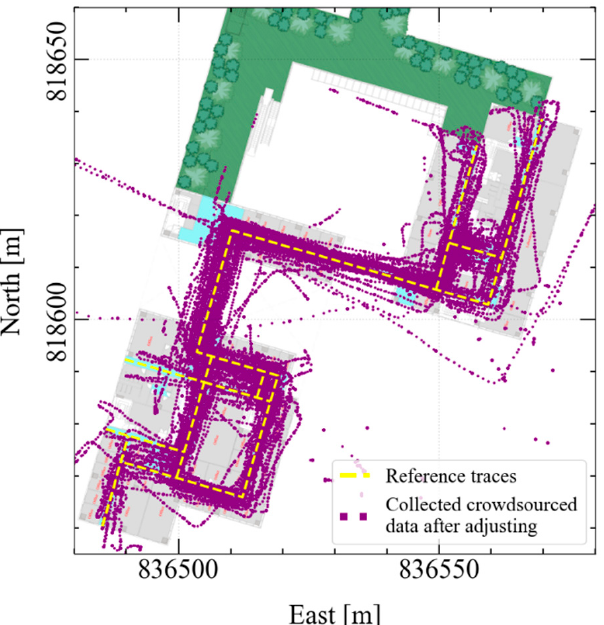
Figure 7. The impact of I/O discrimination on collecting crowdsourced data. It can be observed that although several tracks were walked in the garden area, utilizing the I/O detection approach confined the collected data to indoor and semi-indoor areas (i.e., the GNSS denied areas that lacked localized signatures).